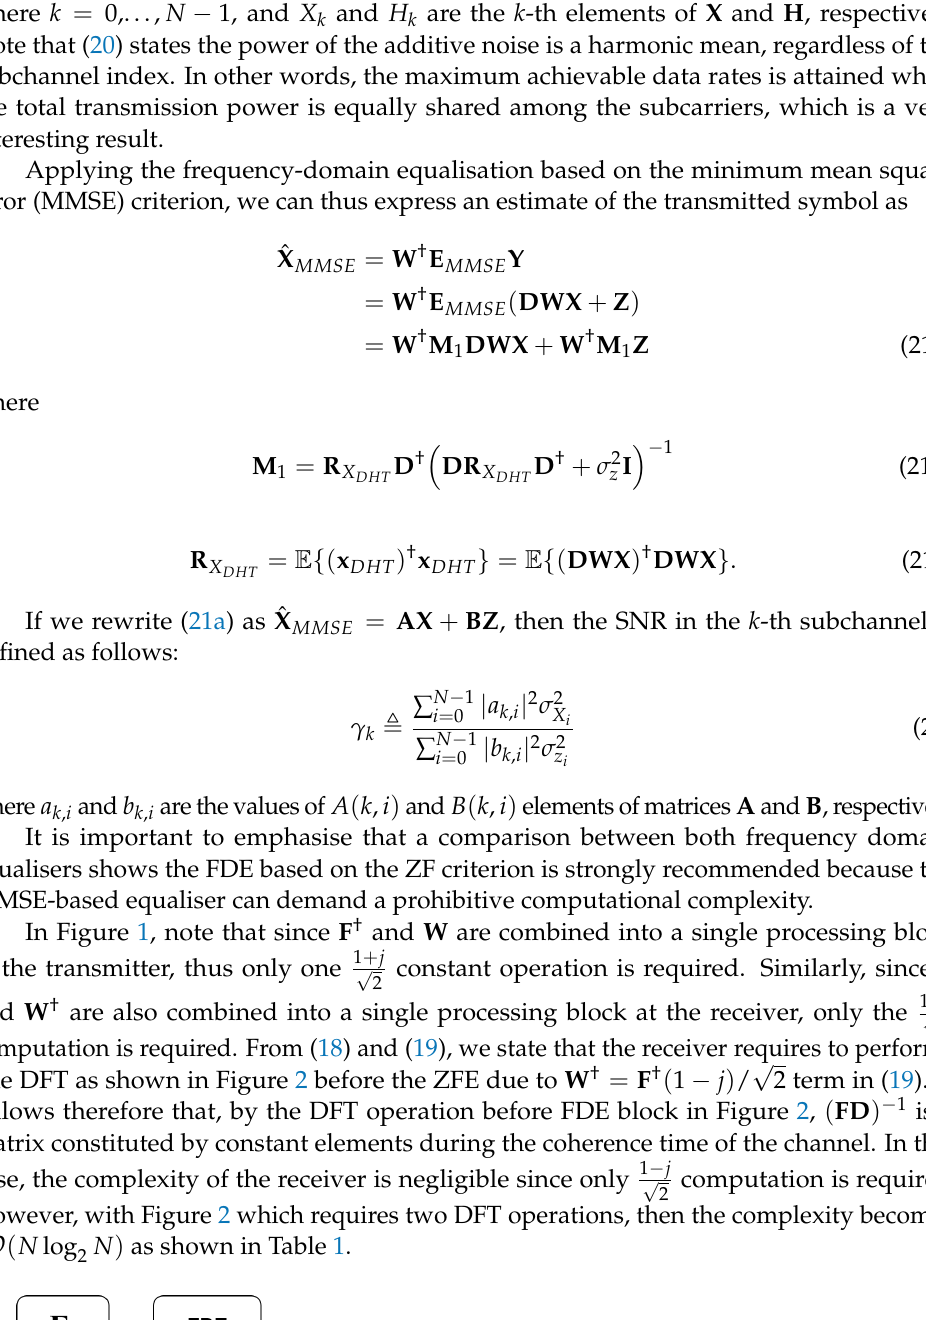
Figure 2. Receiver side showing method of implementing the frequency-domain equalisation detec- tion of FHT-OFDM